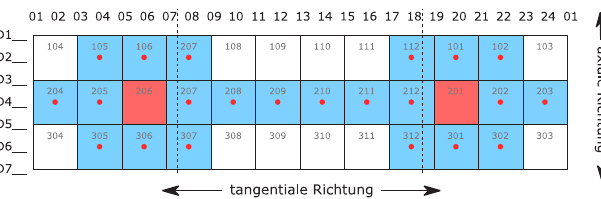
Fig. 5. Sketch of configuration 3). Detectors are positioned in the segment centers within the measurement plane and above and below the segments adjacent to the segment in front of the HPGe-detectors. The detectors in front of the HPGe-detectors are removed.